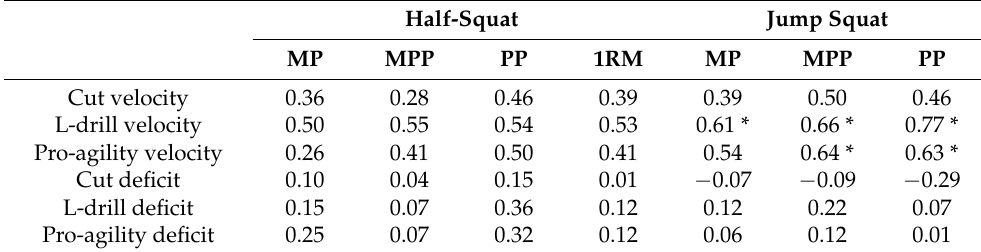
Table 6. Correlation coefficients between change of direction velocity and deficit in the three distinct tested protocols and bar-power outputs and one repetition maximum in the half-squat and jump squat